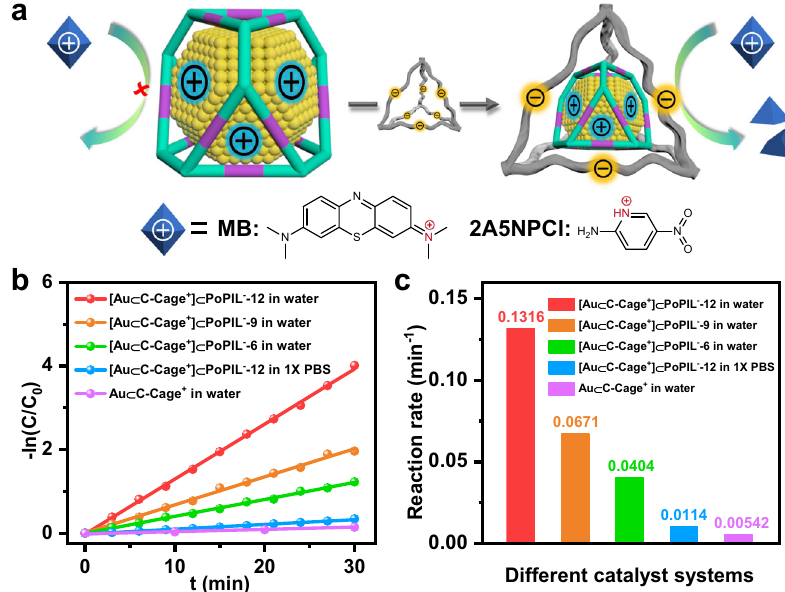
Fig. 3 Charge-selective substrate sorting effect for a series of catalysts. a Schematic illustration of different af fi nity to the cationic substrate using Au ⊂ C- Cage + and [Au ⊂ C-Cage + ] ⊂ PoPIL − catalysts, the formulas of cationic substrates MB and 2A5NPCl are displayed (counteranions are omitted for clarity), ( b ) linear fi tting and ( c ) overall comparison of the reaction rate constant for catalytic degradation of positively charged MB by Au ⊂ C-Cage + (purple) and [Au ⊂ C-Cage + ] ⊂ PoPIL − catalysts with regulable charge density of the anionic PoPIL shell in aqueous media (The charge density can be adjusted by regulating the initial mixing molar ratio between Au ⊂ C-Cage + and SS anion, i.e., from 1:12 to 1:9 and 1:6 in the anion exchange step prior to polymerization, the corresponding catalyst is denoted as [Au ⊂ C-Cage + ] ⊂ PoPIL − -Y, Y = 12 (red), 9 (orange) or 6 (green)). The [Au ⊂ C-Cage + ] ⊂ PoPIL − -12 catalyzed MB degradation in 1X PBS reaction media is also presented (blue). The above experiments were all conducted at 298